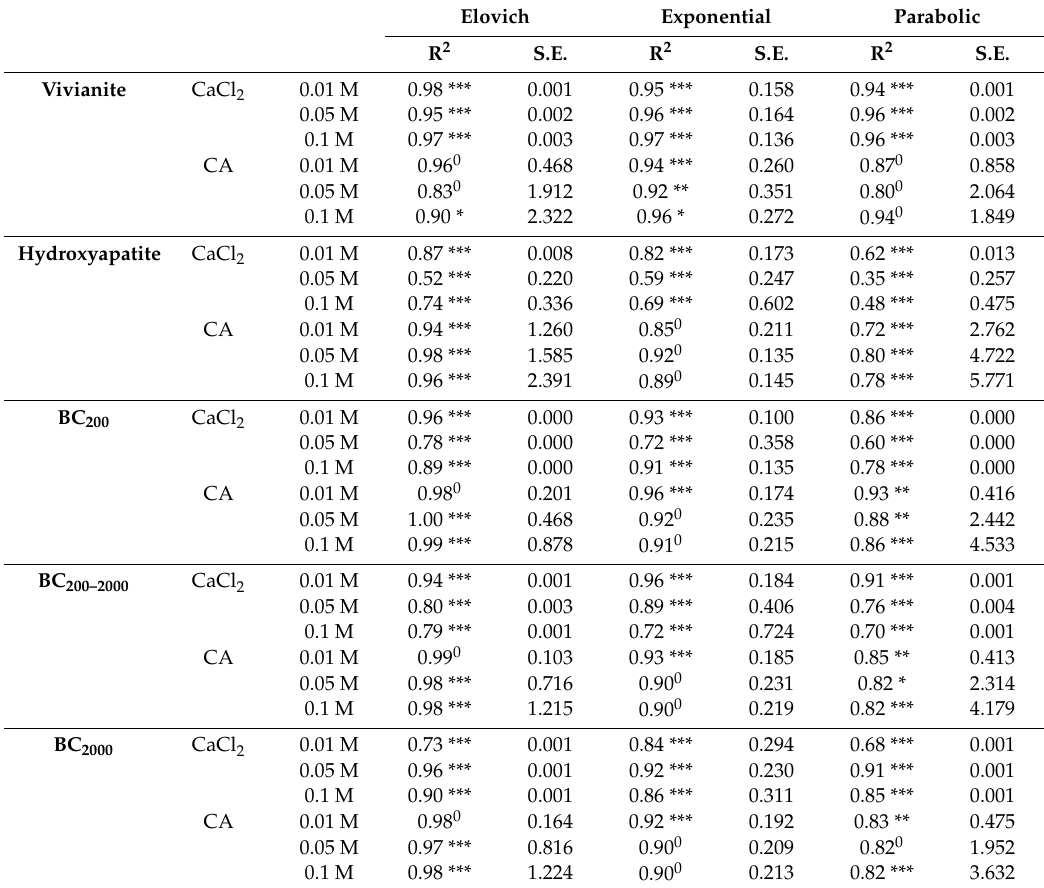
Figure 2. P release kinetics of ( a ) hydroxyapatite and vivianite, as well as ( b ) bone char using citric acid (CA) at pH 6. Table 4. Coe ffi cients of determination (R 2 ) and standard errors (S.E.) for the kinetic equations used to describe the kinetic release of P with CaCl 2 and citric